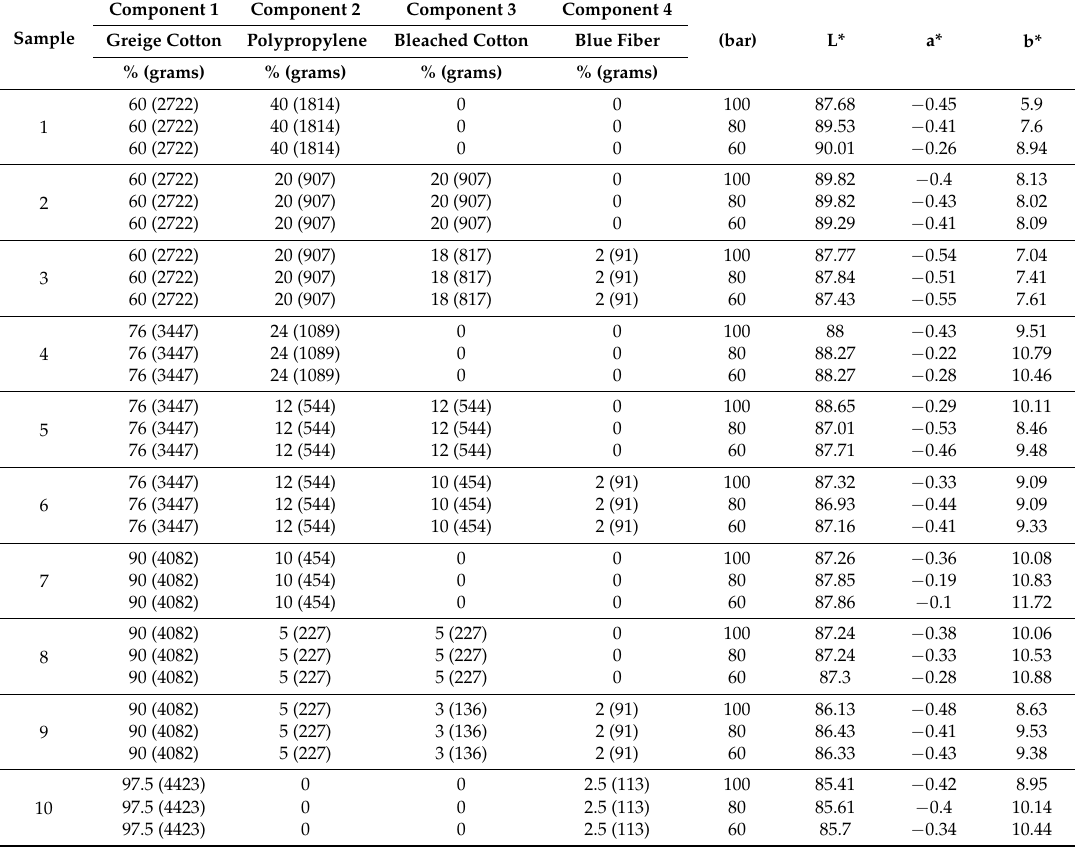
Table 1. Composition and L*a*b* Whiteness Measurement of Hydroentangled Nonwoven Rolls.